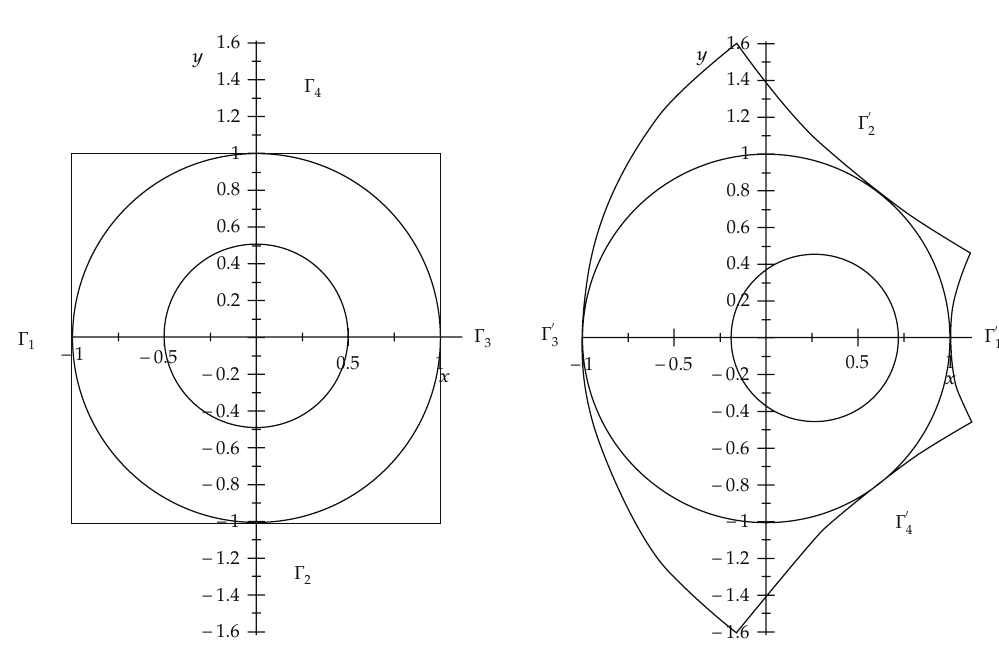
Figure 4: Dirichlet/Neumann problem on (cid:2) and the domain (cid:2) (cid:9) (cid:2) f − 1 (cid:3) (cid:2) (cid:4)